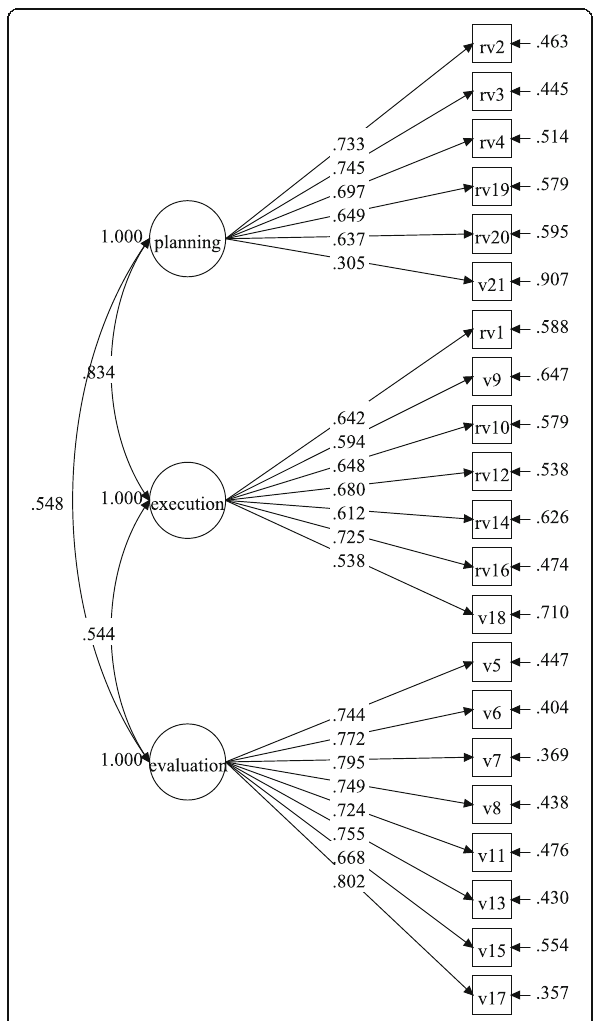
Fig. 3 Factor loadings for the three-factor model in the elementary school group